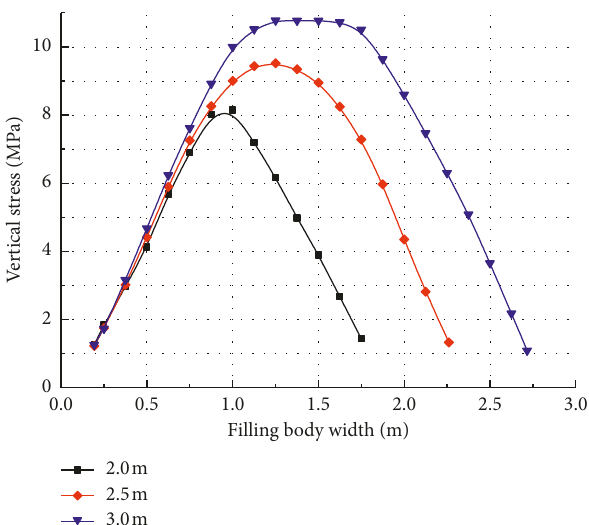
Figure 11: Relations between vertical stress and width of the filling body.